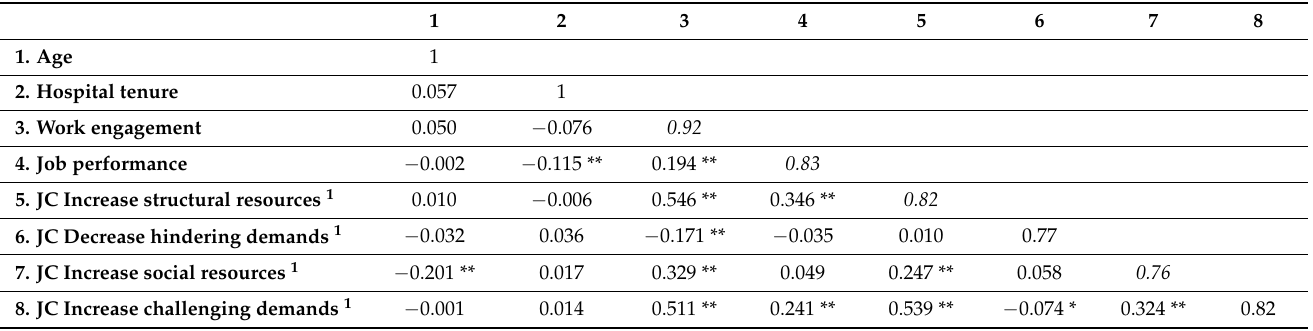
Table 2. Study 1 Pearson’s correlation matrix ( N = 699).